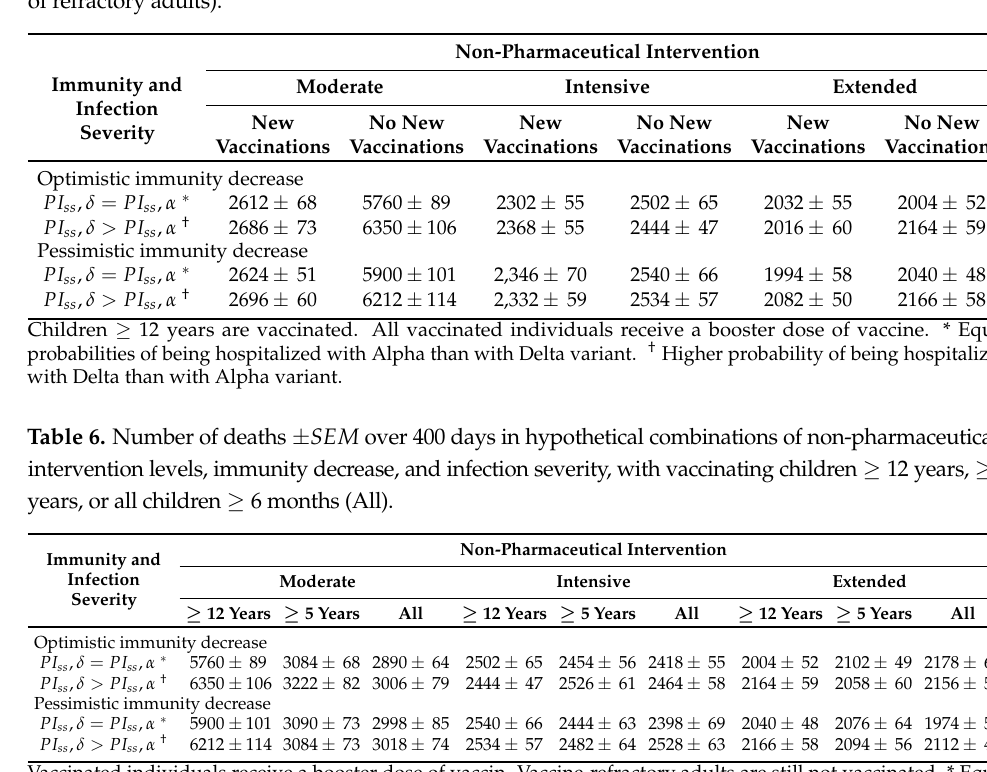
Table 5. Number of deaths ± SEM over 400 days in hypothetical combinations of non-pharmaceutical intervention levels, immunity decrease, and infection severity, with and without new vaccinations (that of refractory adults).